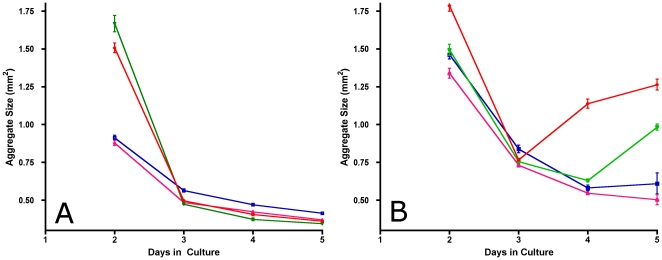
Aggregate size as a function of cell number and time in culture.Compaction assays were performed in which cells for all clones were placed in hanging drop culture at cell seeding densities of 25,000 (A) and 50,000 (B) cells per aggregate and a sFn concentration of 30 µg/ml. Size measurements were initiated on day 2 and repeated daily up to day 5. Each data point represents average size calculated from 10 aggregates per time point for clones expressing Low (blue line), Mid (pink line), High (green line) and Highest (red line) levels of α5β1 integrin.